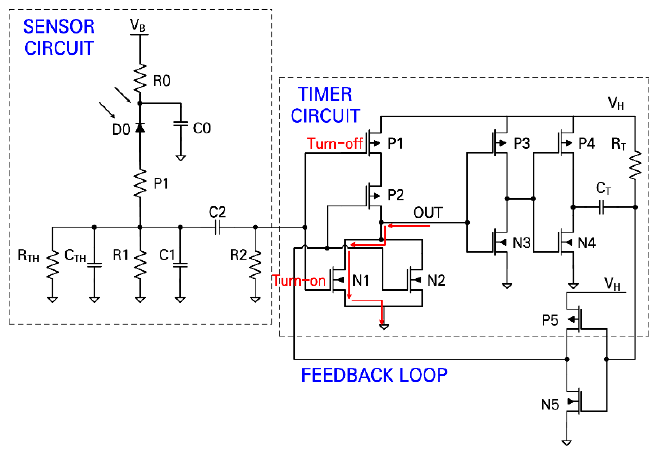
Figure 3. Detailed view of the proposed detection circuit.